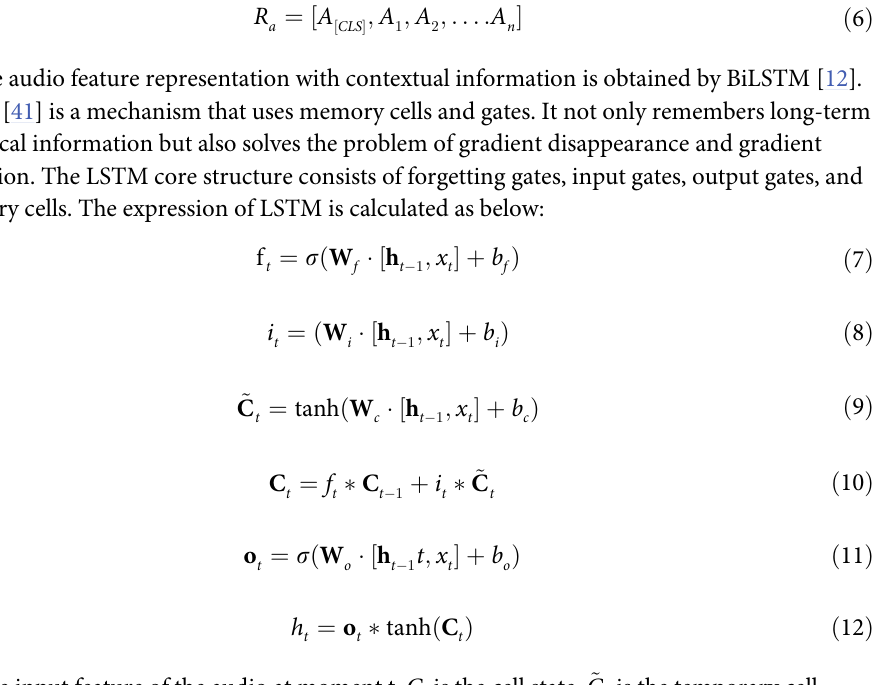
PLOS ONE | https://doi.org/10.1371/journal.pone.0273936 September 9,